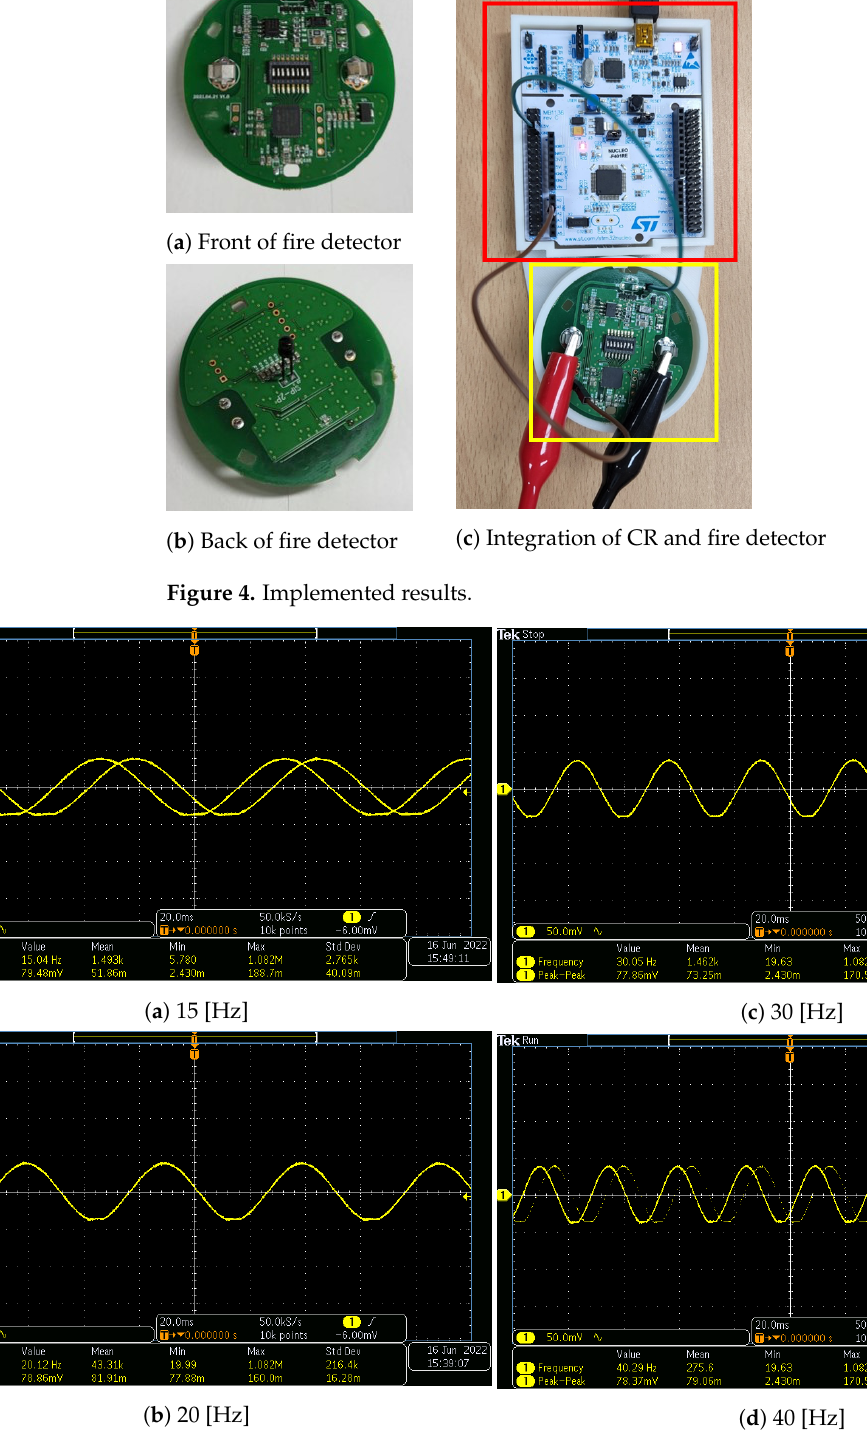
Figure 5. Oscilloscope